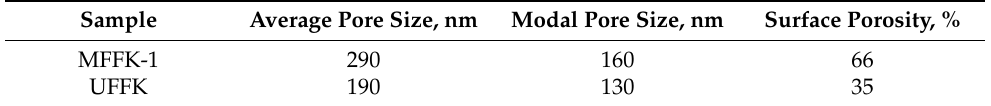
Table 1. Surface porosity of MFFK-1 and UFFK.